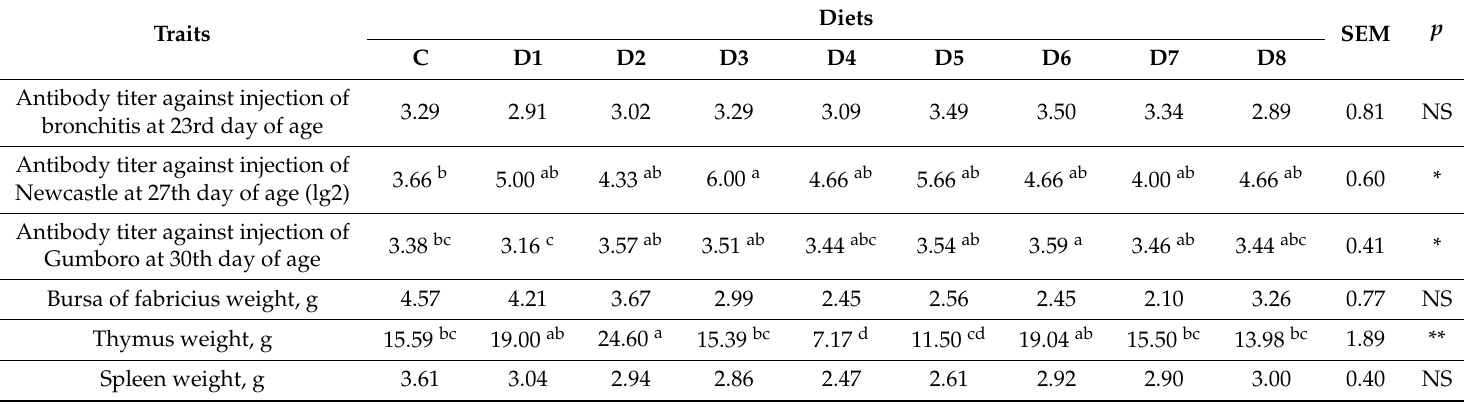
Table 7. Bronchitis, Newcastle, and Gumboro hemagglutination-inhibition (log 10 ) titers of broilers fed on di ff erent levels of L-carnitine and lysine-methionine.